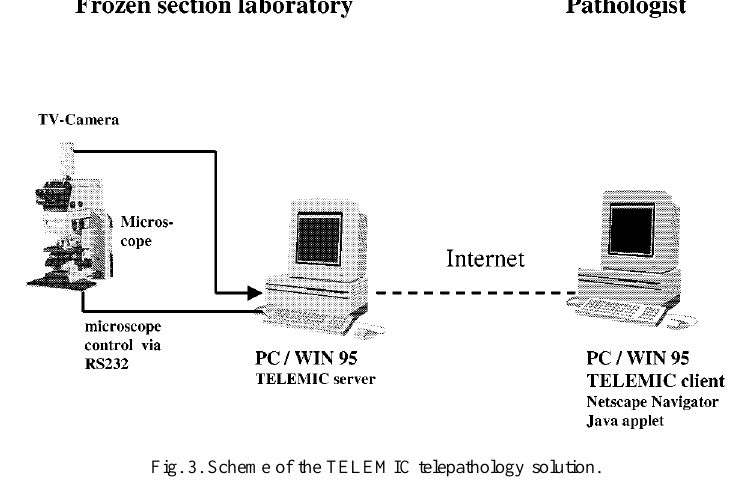
Fig. 3. Scheme of the TELEMIC telepathology